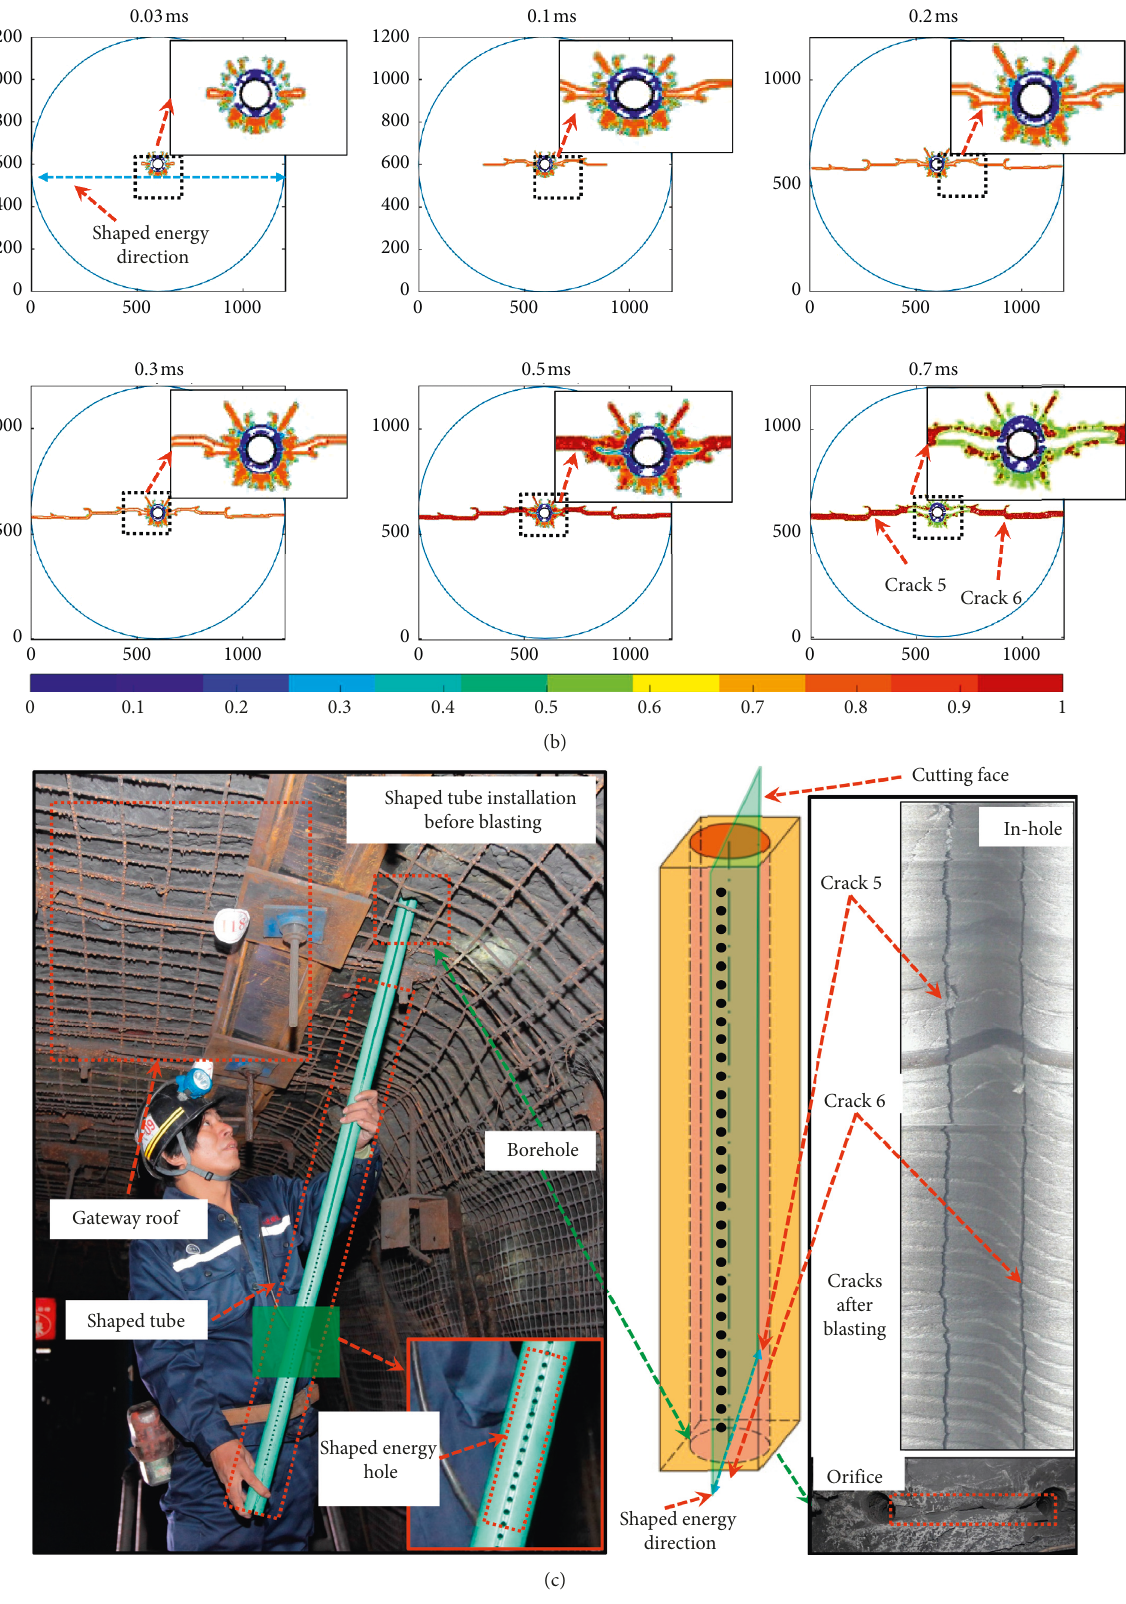
Figure 7: Rock damage crack propagation process after blasting. (a) Conventional method. (b) Automatic adaptive optimization method. (c) Shaped tube installation and cracks after site